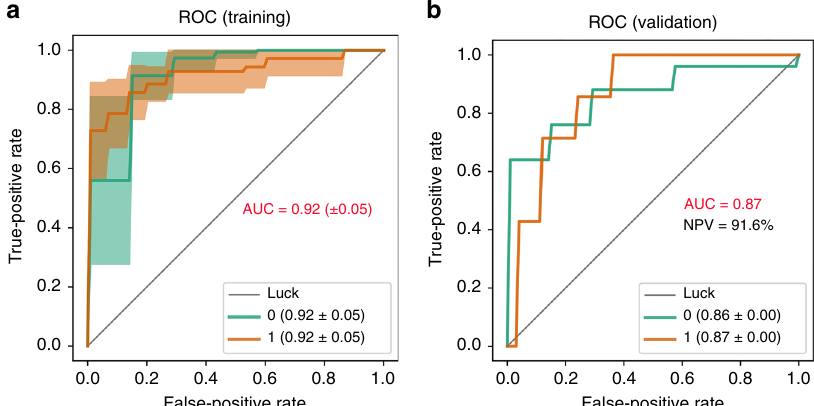
Fig. 4 High diagnostic accuracy of a gut-microbiome signature for the detection of NAFLD-cirrhosis. Receiver operating characteristic (ROC) curves evaluating ability to predict advanced Fibrosis using Random Forest classi fi cation. Each curve represents the sensitivity and speci fi city to distinguish subjects with NAFLD-cirrhosis (1, brown line) from non-NALFD controls (0, green line). a Mean ROC curve from cross-validation within training data comprised of NAFLD-cirrhosis probands ( n = 24) and non-NAFLD controls ( n = 47). Cross-validation was performed by iteratively (10 times) training the Random Forest model with 70:30 train/test split on this training data. b ROC curve representing diagnostic accuracy of Random Forest classi fi cation model tested on fi rst-degree relatives of NAFLD-cirrhosis probands ( n = 32). The negative predictive value (NPV) of the model was 91.6% and the positive predictive value was 62.5%. Source data are provided as a Source Data fi le NATURE COMMUNICATIONS| (2019) 10:1406 |https://doi.org/10.1038/s41467-019-09455-9|www.nature.com/naturecommunications